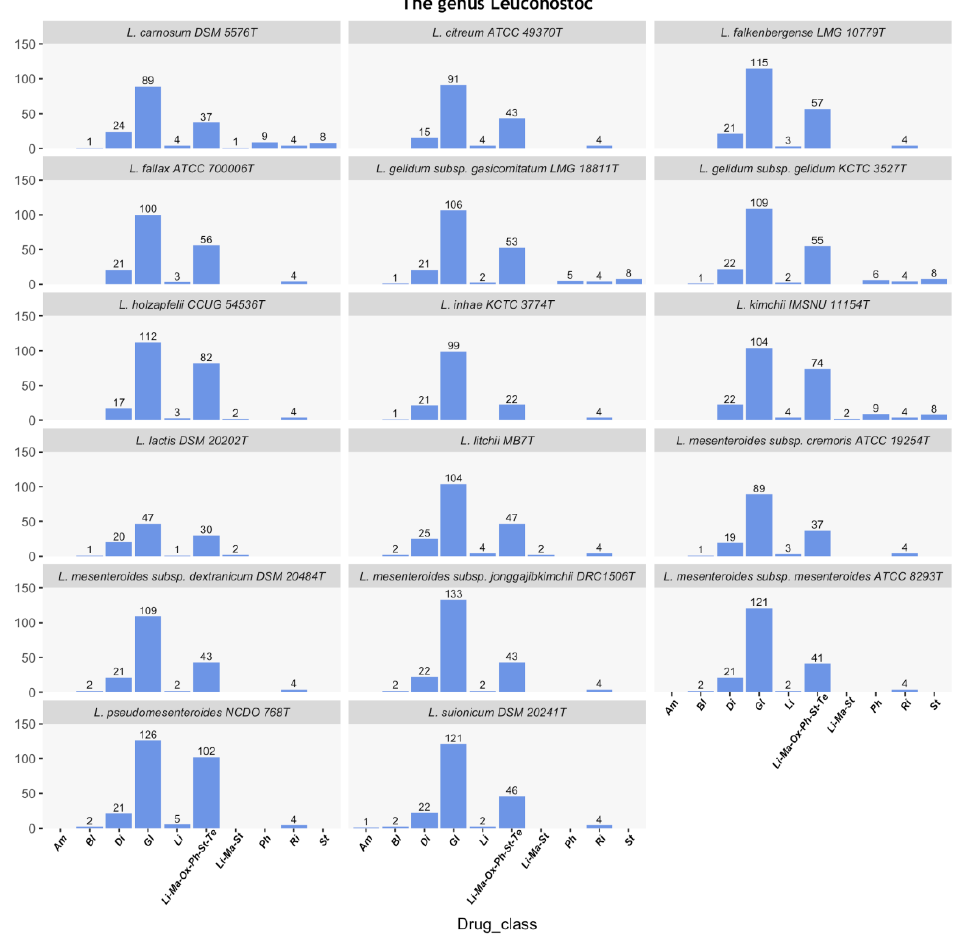
Figure 1. Putative antibiotic resistance (AR) genes identified in Leuconostoc spp. Putative antibiotic resistance genes (ARGs) detected are reported for each strain of the dataset. They are involved in the resistance towards aminoglycosides (Am), beta-lactams (Bl), diaminopyrimidines (Di), glycopeptides (Gl), lincosamides (Li), ABC-F ATP-binding cassette ribosomal protection protein ABC cassettes (Li-Ma-Ox-Ph-St-Te), erythromycin (Li-Ma-St), chloramphenicol (Ph), rifampicin (Ri) and streptogramins (St). The number of hits per drug class is reported on each barplot. Among the hits obtained, WP_031941011.1 of L. pseudomesenteroides NCDO 768 T and WP_010008491.1 of L. fallax ATCC 700006 T were found to have high similarities (51.8% and 58.9%, respectively) with the LsaA protein of E. faecalis ATCC 29212 in the CARD database and as such were further investigated.